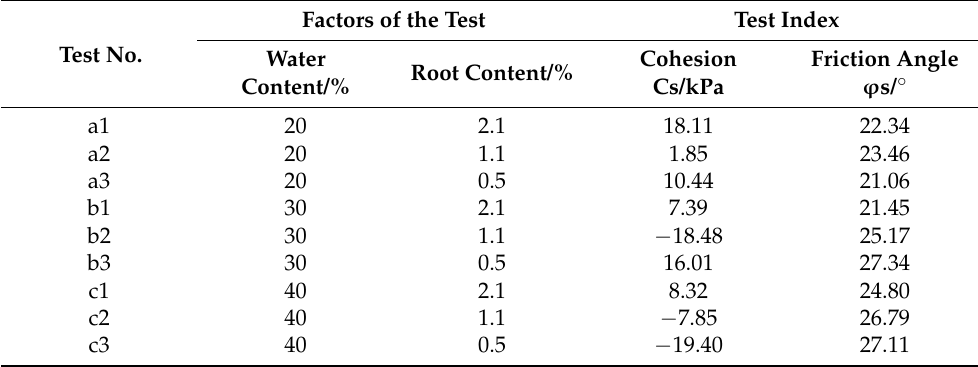
Table 7. Testing of Water Content and Root Content on Shear Strength and Index of Root–soil